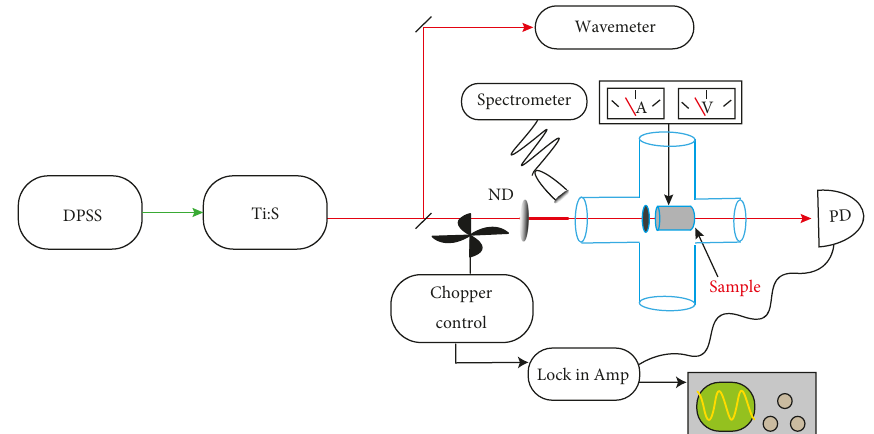
Figure 3: Schematic diagram of the experimental setup.